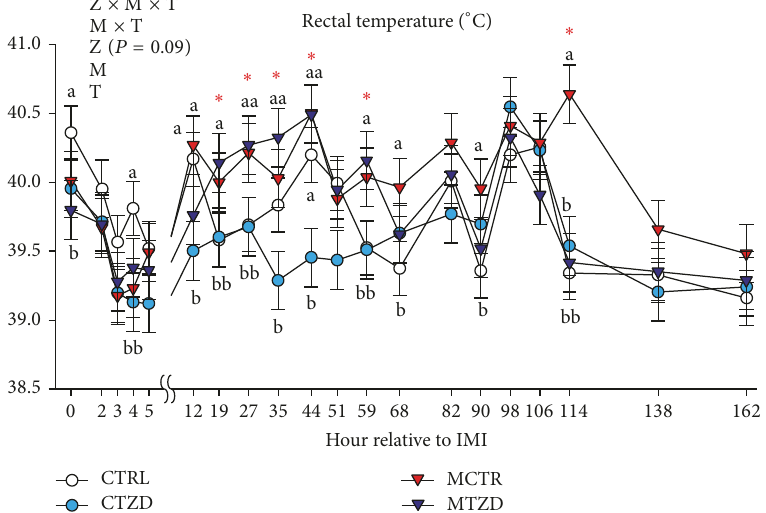
Figure 2: Rectal temperature recorded for several hours after intramammary infusion (IMI) of Strep. uberis (M) or saline in goats receiving daily intrajugular injection of 2,4-thiazolidinedione (TZD) or saline (CTR). Significant ( 𝑃 ≤ 0.05 ) effects and interactions are indicated in the graph (mastitis: M, time: T, and TZD: Z). The 𝑃 value for tendency of TZD effect is reported. Significant effect of M × T is denoted with red asterisk and different letters denote significant differences. Letters denoted significant differences between groups at the same time